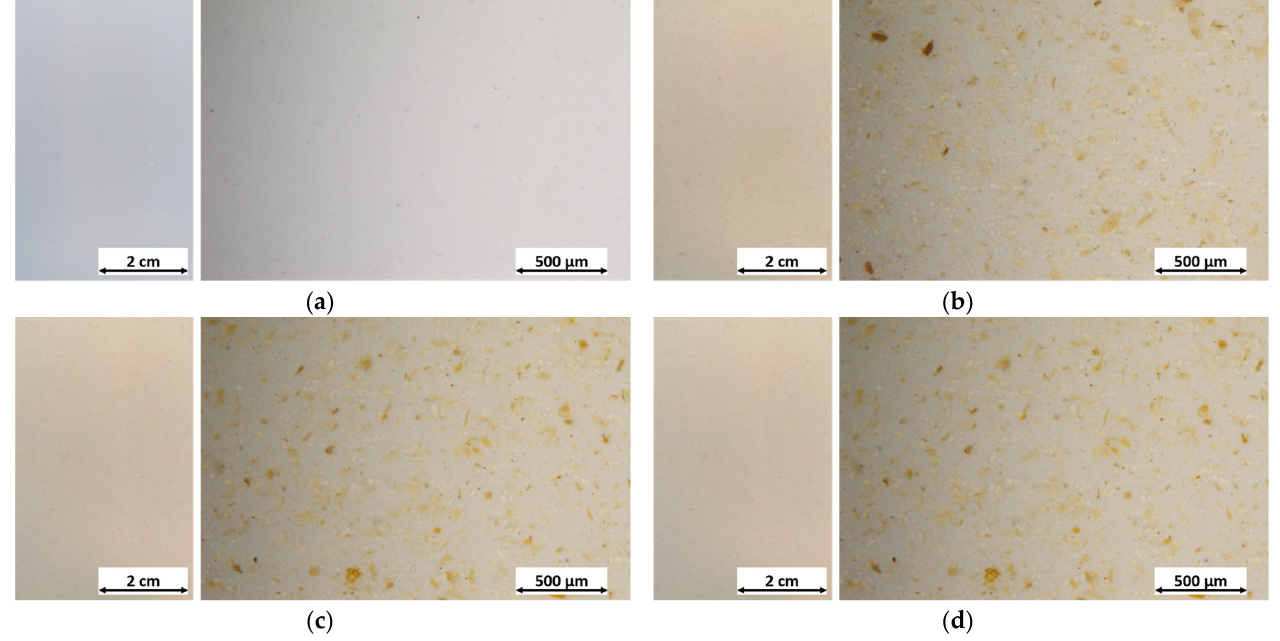
Figure 3. Top view micrographs of ( a ) sample T, ( b ) sample O, ( c ) sample S, and ( d ) sample W.